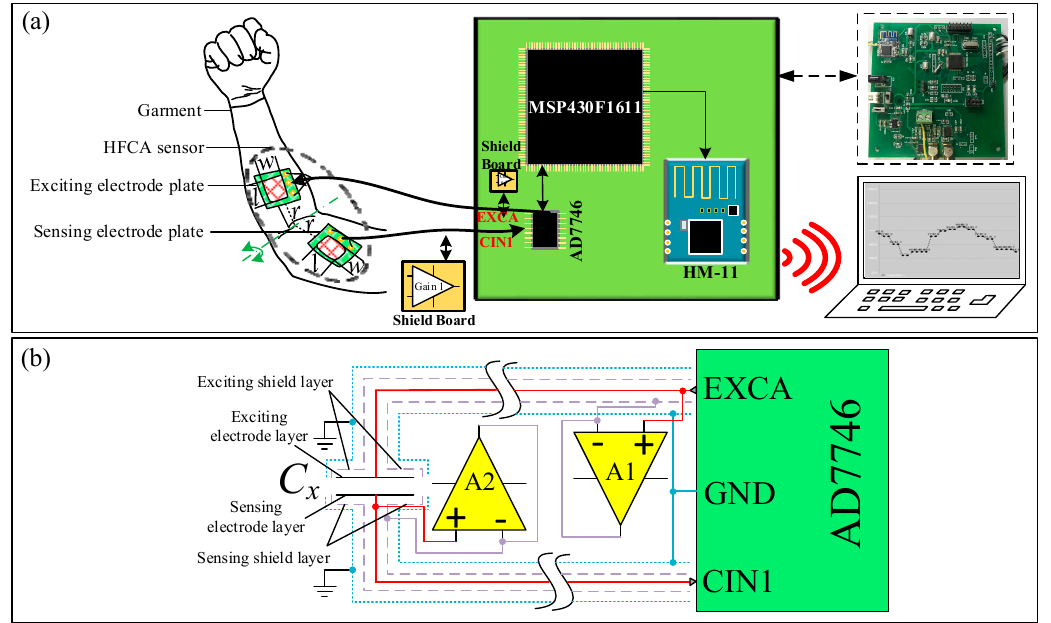
Figure 1. The NFCAS ( a ) Prototype detection system; ( b ) Detection circuit with drive cable technology. A micro-capacitance detection chip (AD7746, Analog Devices, Inc., Norwood, MA, USA) [17] was